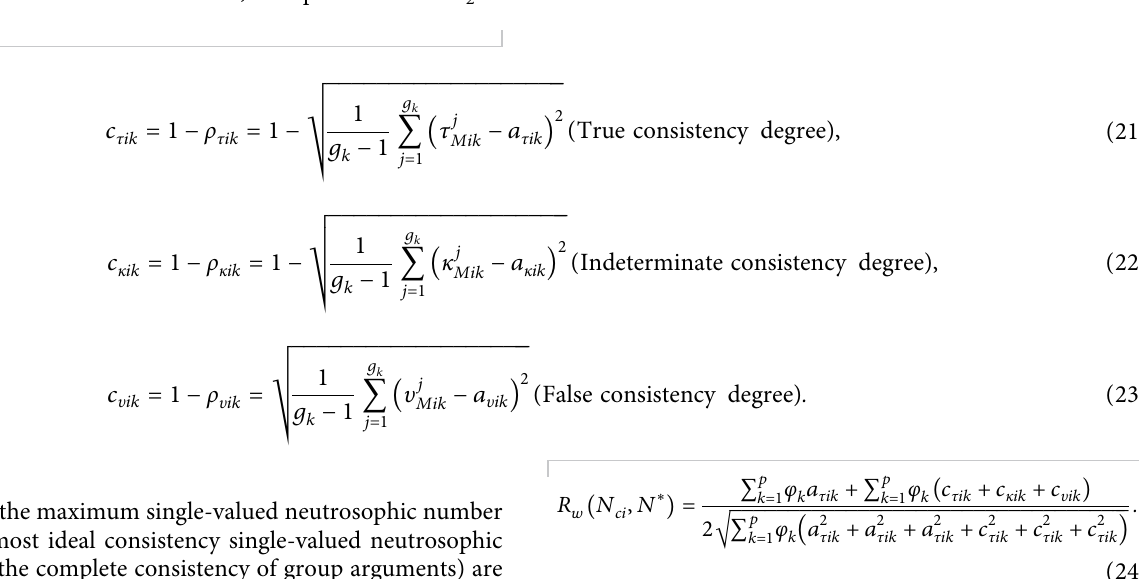
Table 2: Standard deviations of all the measure values and the sorting results of the six alternatives. Measure method Measure value